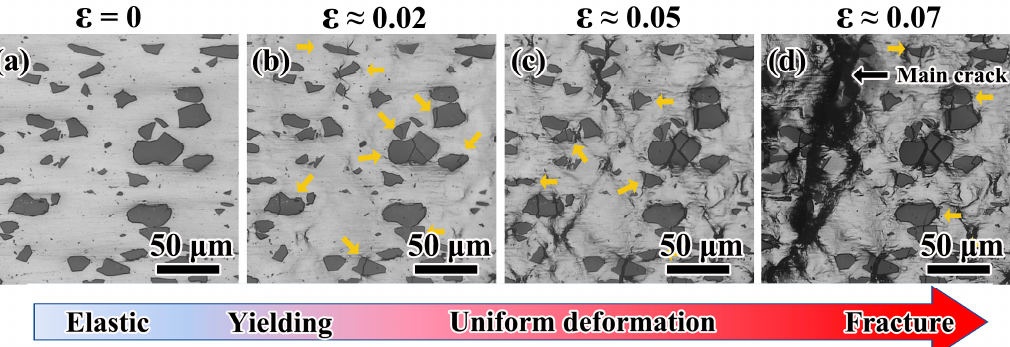
Figure 3. The typical damage evolution at the strain of ( a ) 0, ( b ) 0.02, ( c ) 0.05, and ( d ) 0.07 with a horizontal loading di- rection. The particles pointed by yellow arrows are the new cracked particle at their corresponding strain.